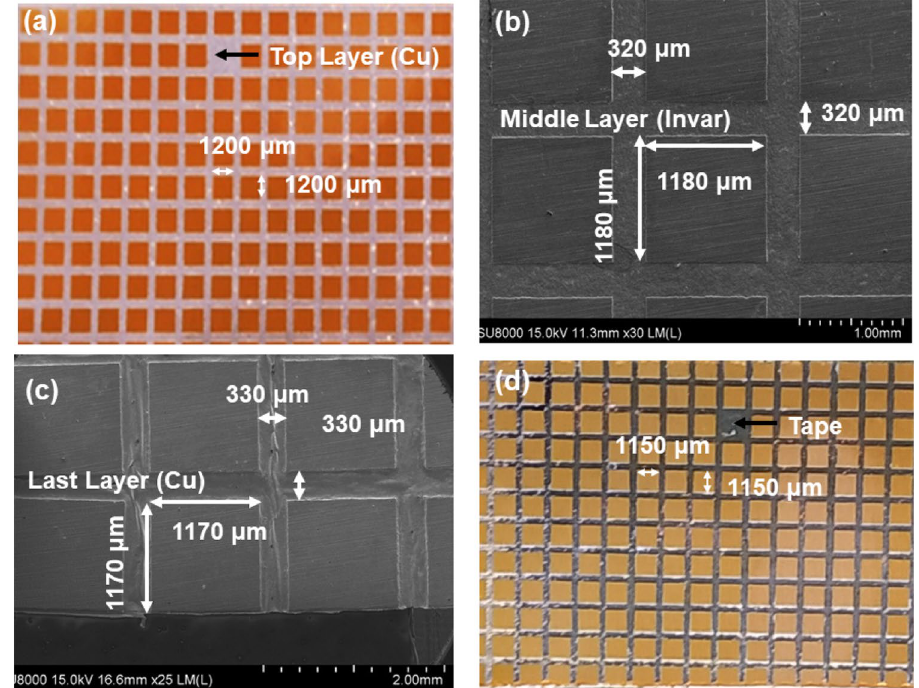
Figure 2. Chip dimensions before and after wet etching from the back side of the CIC for dicing: ( a ) OM image of the chip pattern before the etching process; ( b ) SEM image of the middle layer (Invar); ( c ) SEM image of the last layer (Cu); ( d ) OM image of the diced chip.